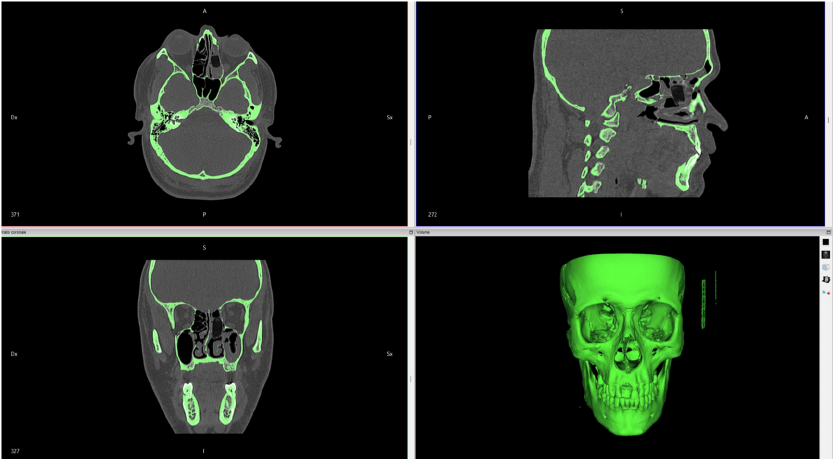
Appl. Sci. 2023 , 13 , 98 Figure 2. Invesalius software digital workflow. The imported file DICOM is transformed into a 3D image.